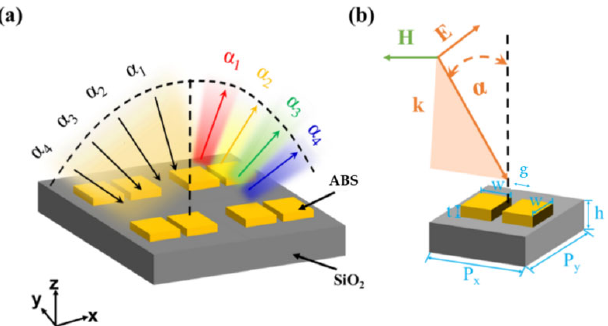
Figure 1. Schematic of terahertz absorption enhancement detection based on the angle ‐ multiplexing of the dielectric metasurface. ( a ) Angle ‐ multiplexing principle of dielectric metasurface with the several incidence angles of α , such as α 1 – α 4 ; ( b ) The unit cell structure of the metasurface. The transverse magnetic field H of TM polarized incident wave is along the y ‐ axis.